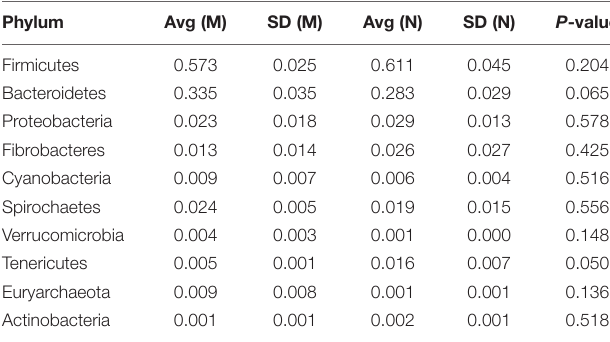
TABLE 6 | Relative abundance of the top 10 most abundant bacterial phyla in blue